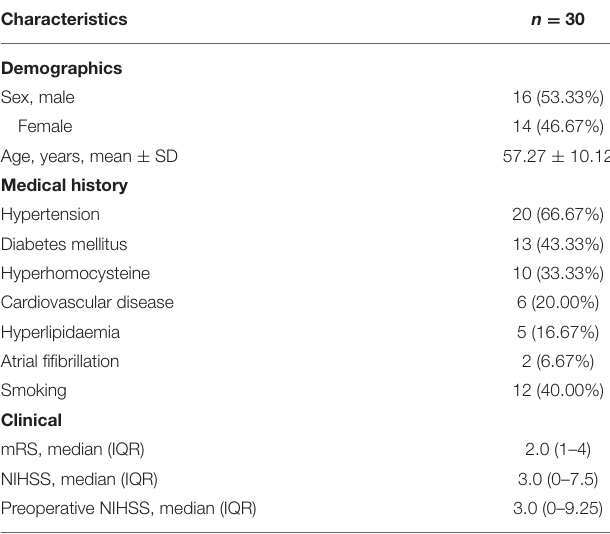
TABLE 1 | Baseline demographic and clinical characteristics of